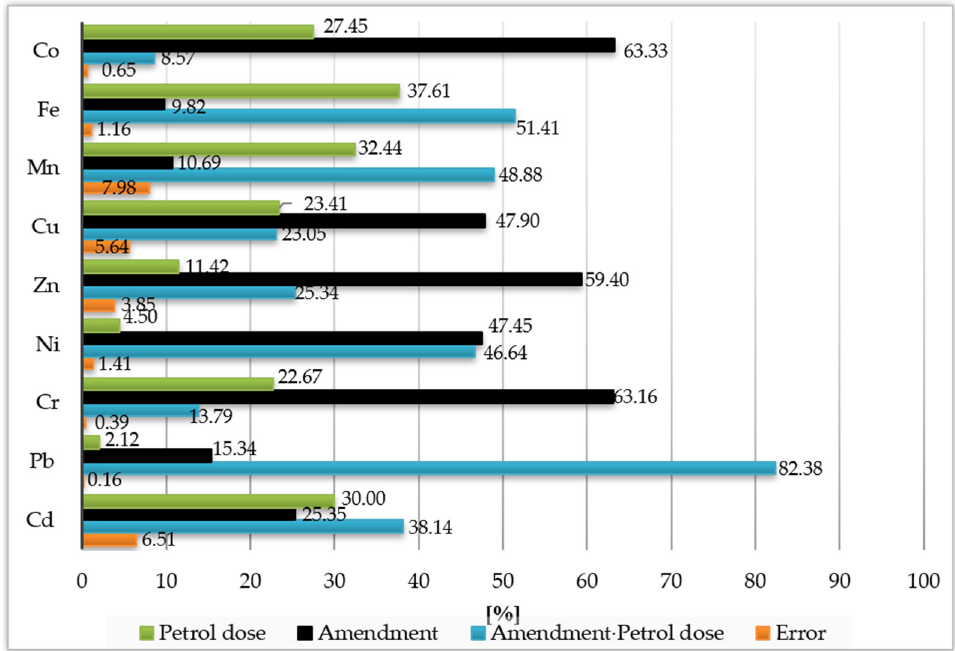
Figure 3. The percent contribution of variable factors according to the content of trace elements in the soil.